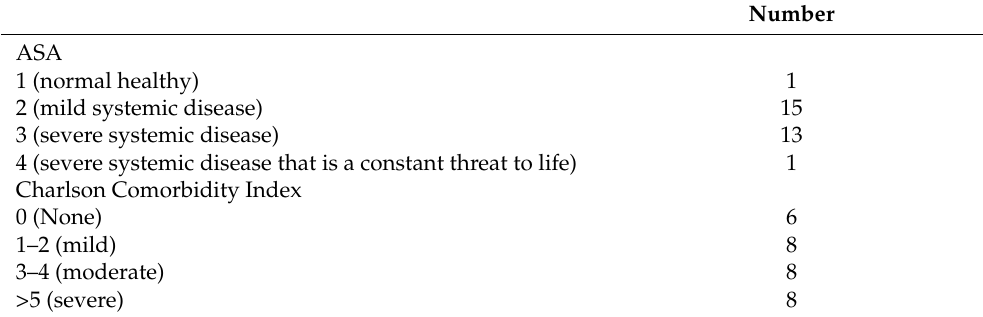
Table 1. Fourteen patients had severe systemic disease and 16 patients had a moderate to severe CCI score. Table 1. Patient ASA and Charlson Comorbidity Index at first-stage revision.